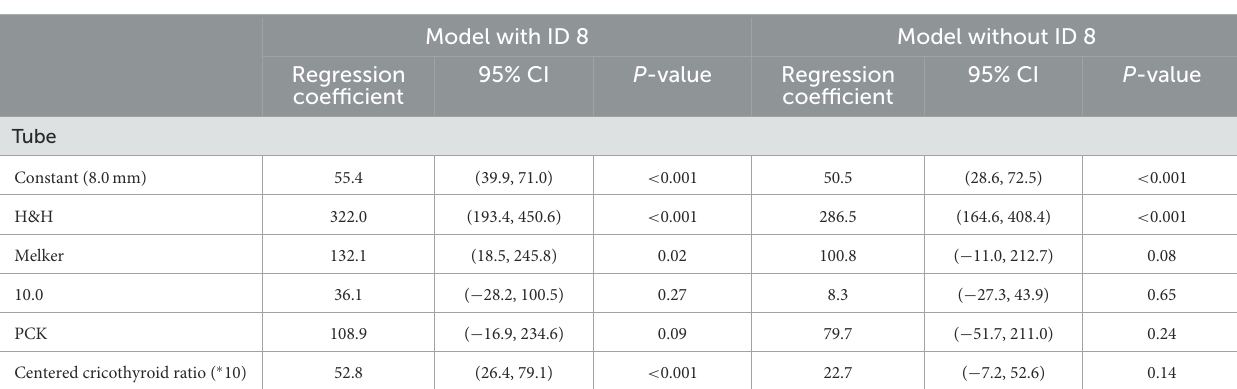
TABLE 3 Linear regression model estimates, with and without dog ID 8.